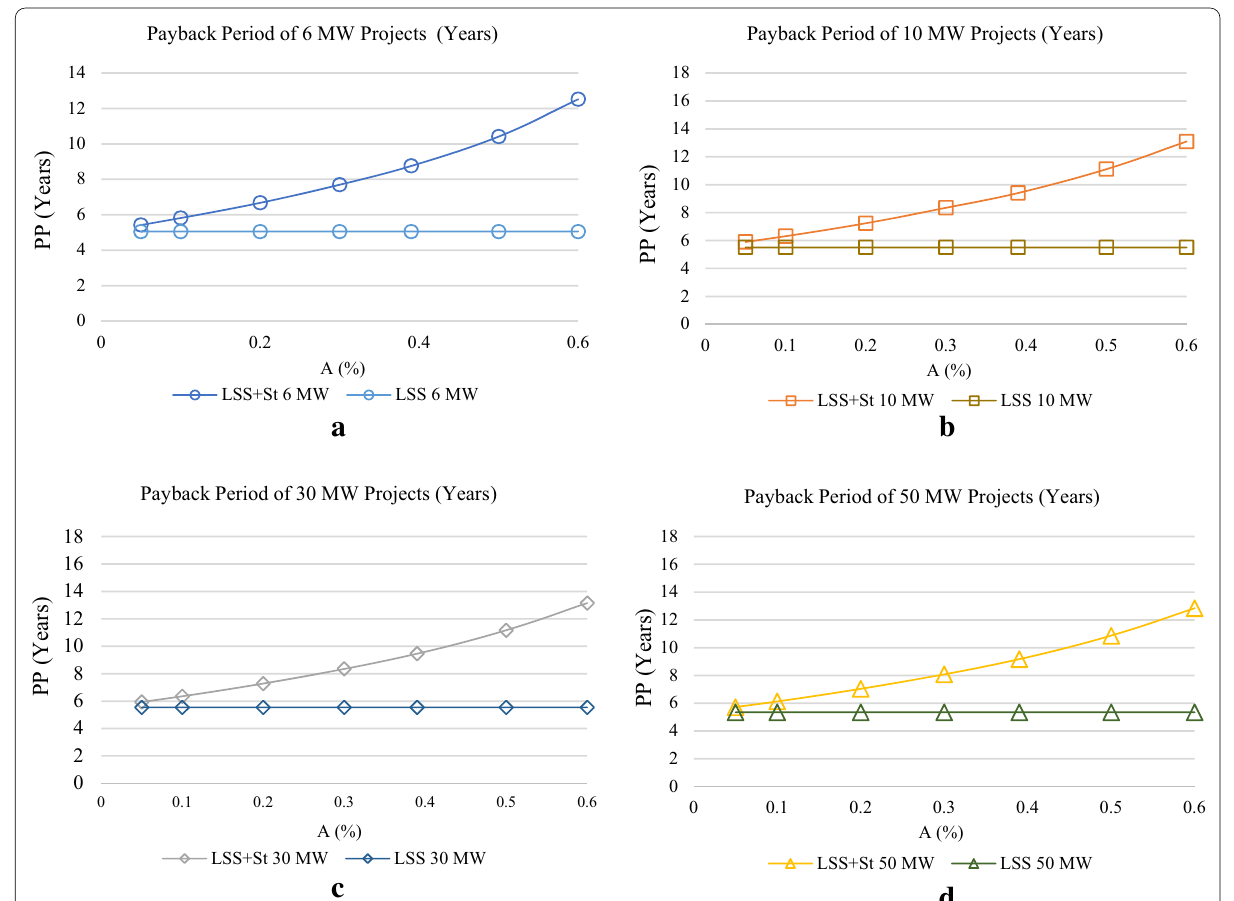
Fig. 15 Payback period of the different investment types for each LSS capacity in Perak. a 6-MW projects, b 10-MW projects, c 30-MW projects, d 50-MW